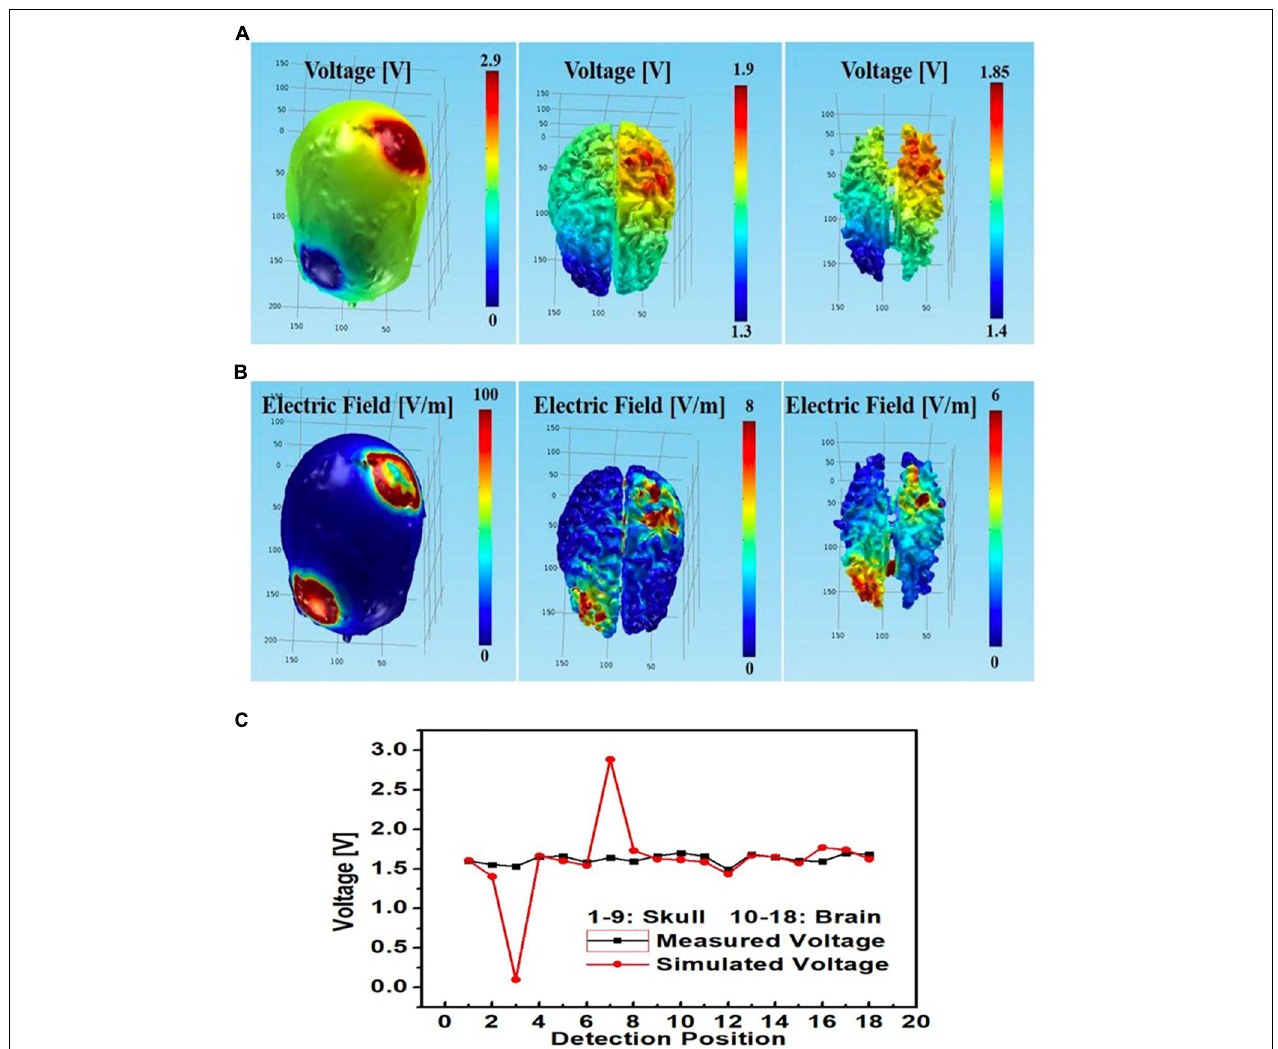
FIGURE 11 | Left PMC anode and right supraorbital cathode montage using circular star array electrodes for stimulation; simulated (A) electric potential and (B) electric field in skull (left), gray matter (middle) and white matter (right); (C) simulated and measured voltages at the nine monitoring electrodes in the skull and brain